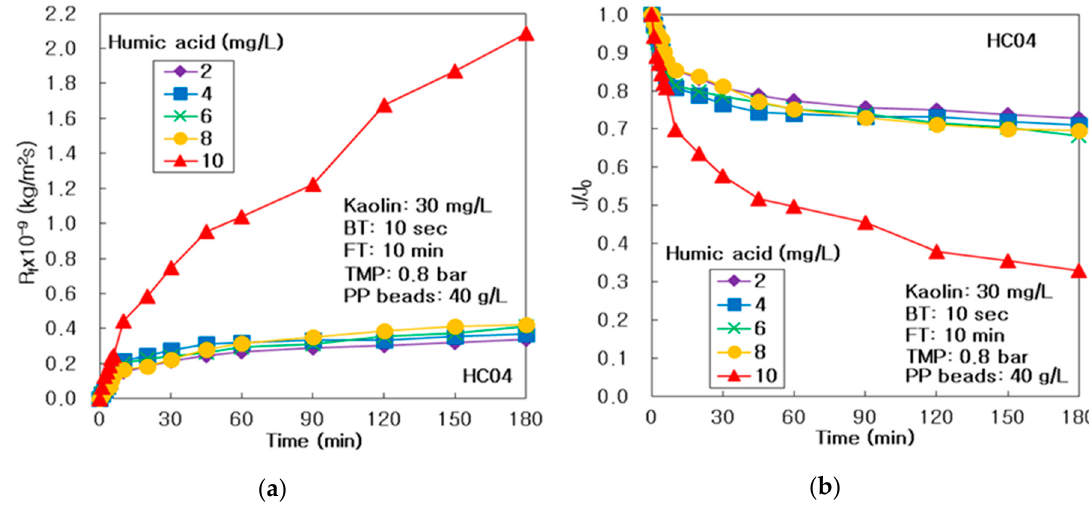
Figure 3. Influence of humic acid in the integrated system, of multichannel ceramic MF and pure PP particles, using UV radiation and periodic air backwashing: ( a ) Membrane fouling resistance and ( b ) dimensionless treated flux.